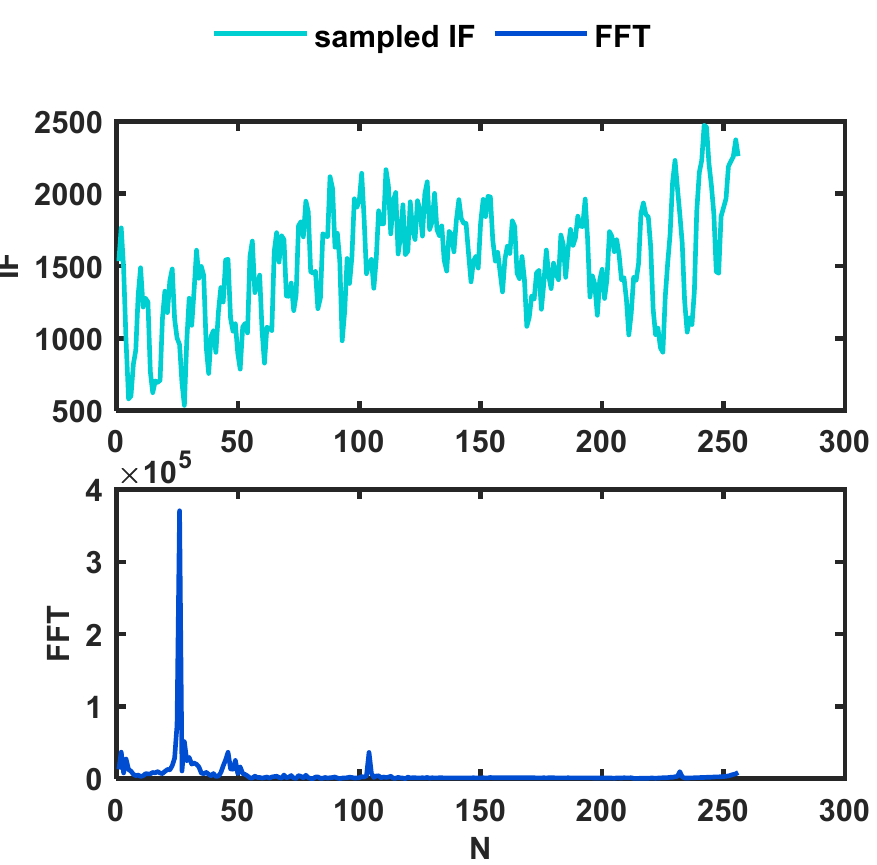
Figure 2. Sampled IF of time domain and frequency domain.